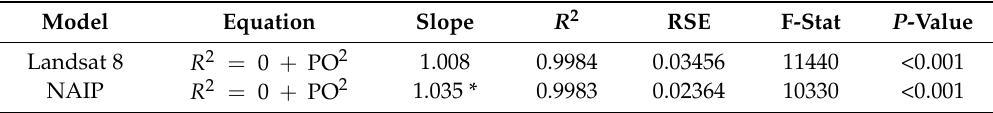
Table 2. Linear regression statistics for 19 independently random images, given the average proportion of overlap (PO) determined by sample unit size and simulated co-registration errors.